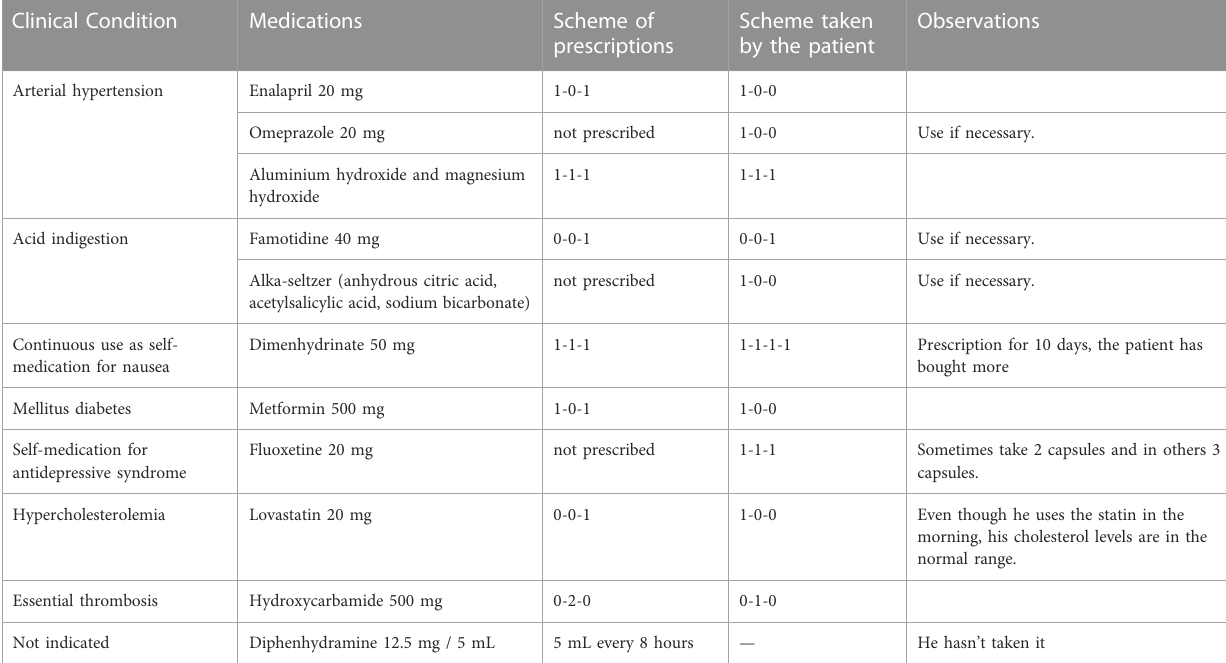
TABLE 1 Summary of Assessment of the Patient ’ s Drug-related Needs. Clinical Condition